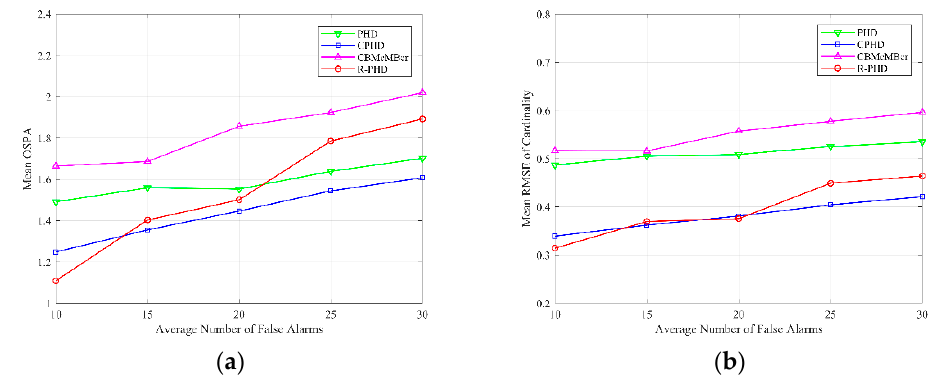
Figure 6. OSPA and cardinality performances of different methods with respect to different average numbers of false alarms from λ = 10 to λ = 30 ( p D = 0.95): ( a ) mean OSPA; ( b ) mean RMSE of cardinality.